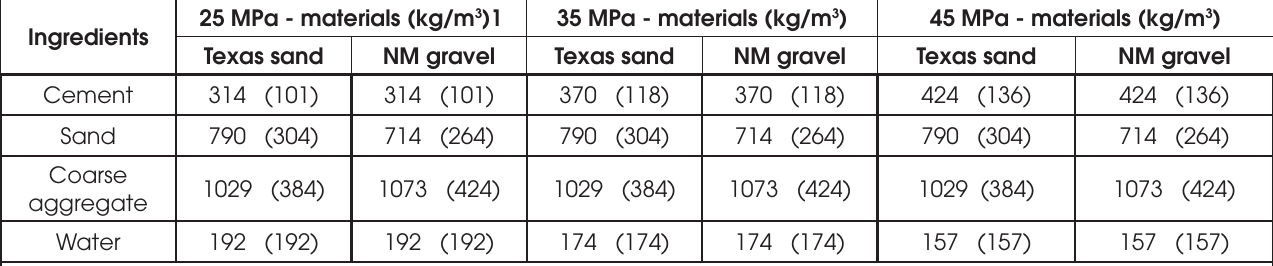
Concrete mix designs used in the study